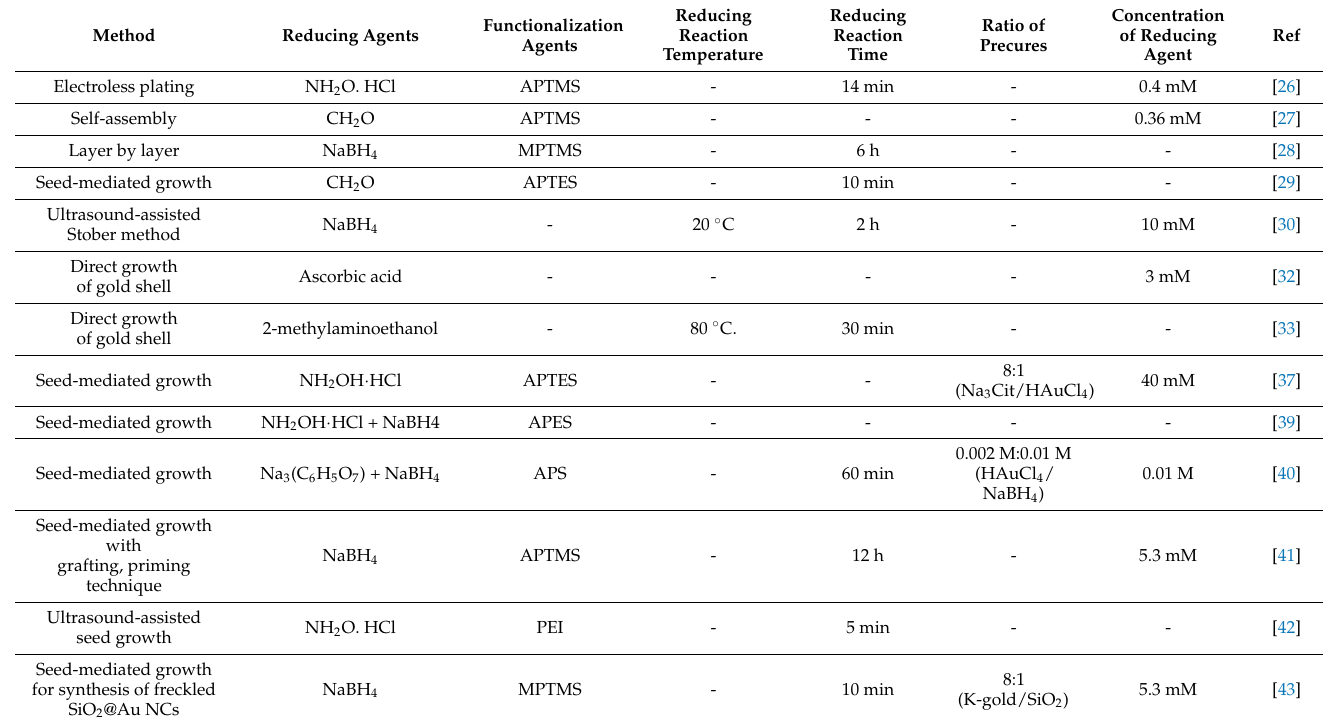
Table 1. A review of the methods and related conditions for the fabrication of SiO 2